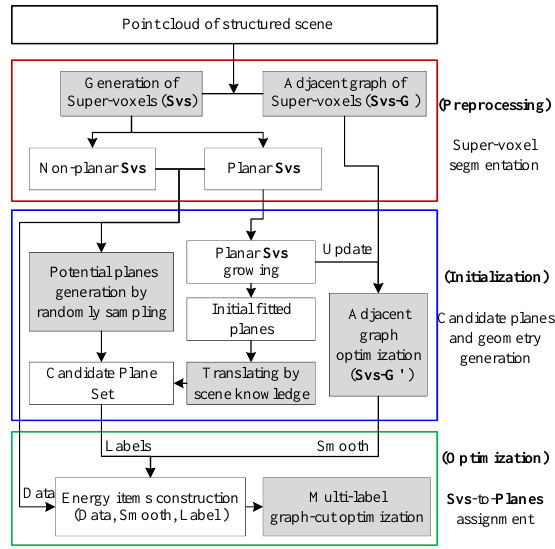
Figure 1. The illustration of the proposed method The structured scenes are a dominant element of three- dimensional modelling, which exists lots of planar surfaces and valuable scene priors as orthogonality, parallelism. Taking the point cloud of a structured scene as input, an over-segmentation preprocessing (Section 3.1.1) is introduced to segment the point clouds into super-voxels (Svs) and its adjacent geometric relations graph (Svs-G), then voxels can be classified as planar or non-planar segments with its geometrical characteristic (Section 3.1.2). To enrich the potential candidate planes, a randomly sampling strategy (Section 3.2.1) and a scene prior- based translating of fitted grouped planar Svs (Section 3.2.2)